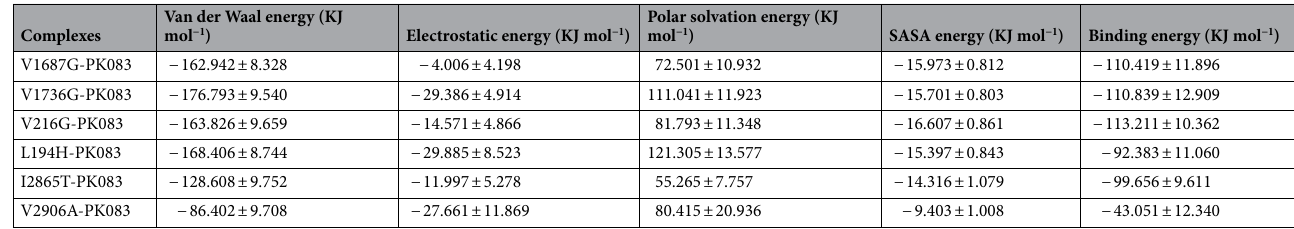
Table 7. MM/PBSA calculations of binding free energy for six mutant-PK083 complexes from 1st MD production run.